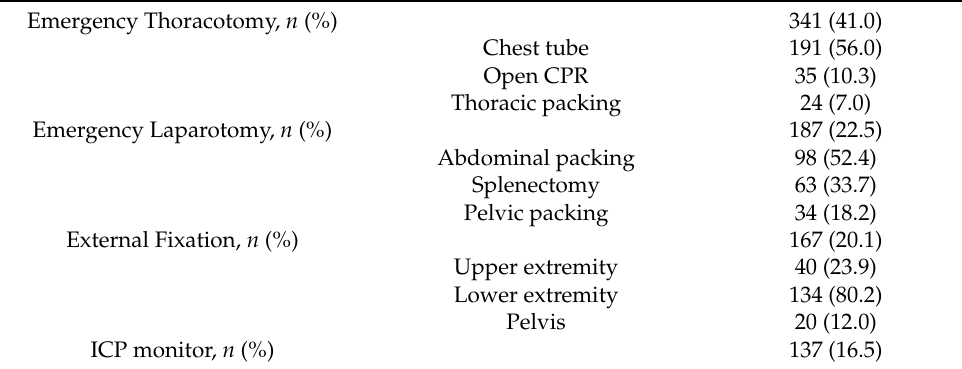
Table 3. The most common surgical interventions within 24 h.